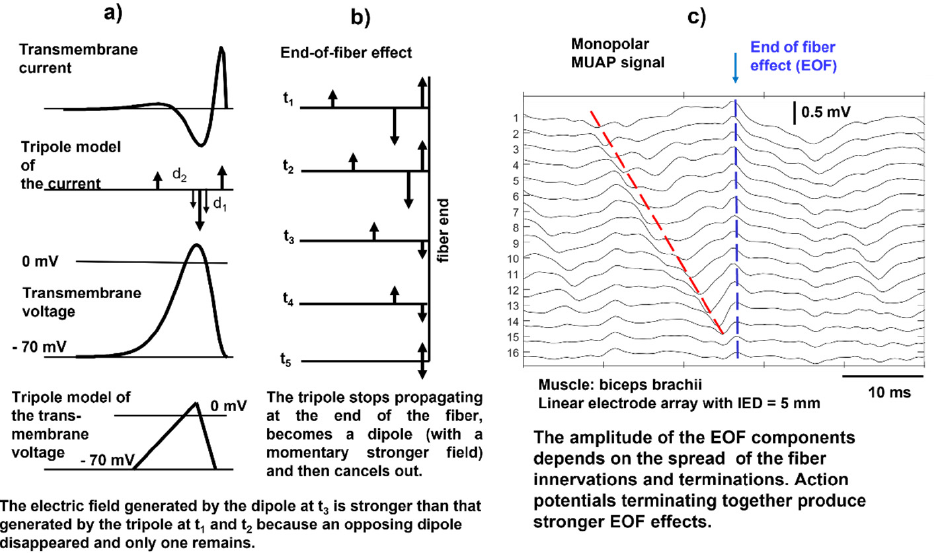
Figure 10. ( a ) Schematic representation of the transmembrane current as two opposite dipoles (a tripole) of current, which implies the representation of the action potential as a triangular waveform; ( b ) extinction of the tripole at the end of the fiber, where the dipole d 1 shrinks (at times t 1 and t 2 ) and disappears (at time t 3 ), leaving dipole d 2 whose field is no longer partially canceled by d 1 . As d 2 shrinks and disappears (at times t 4 and t 5 , respectively), the surface potential disappears; ( c ) example